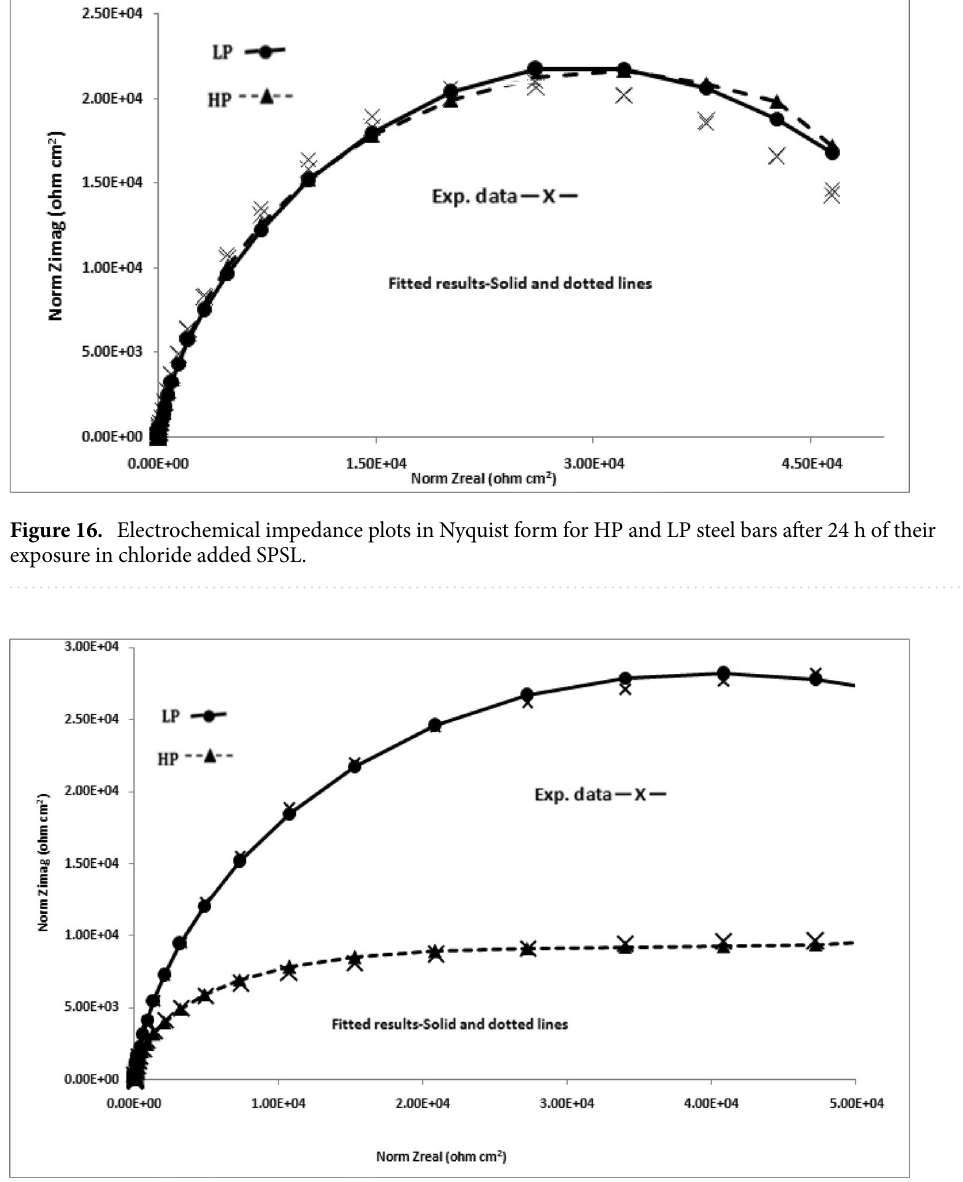
Figure 17. Electrochemical impedance plots in Nyquist form for HP and LP steel bars after 192 h of their exposure in chloride added